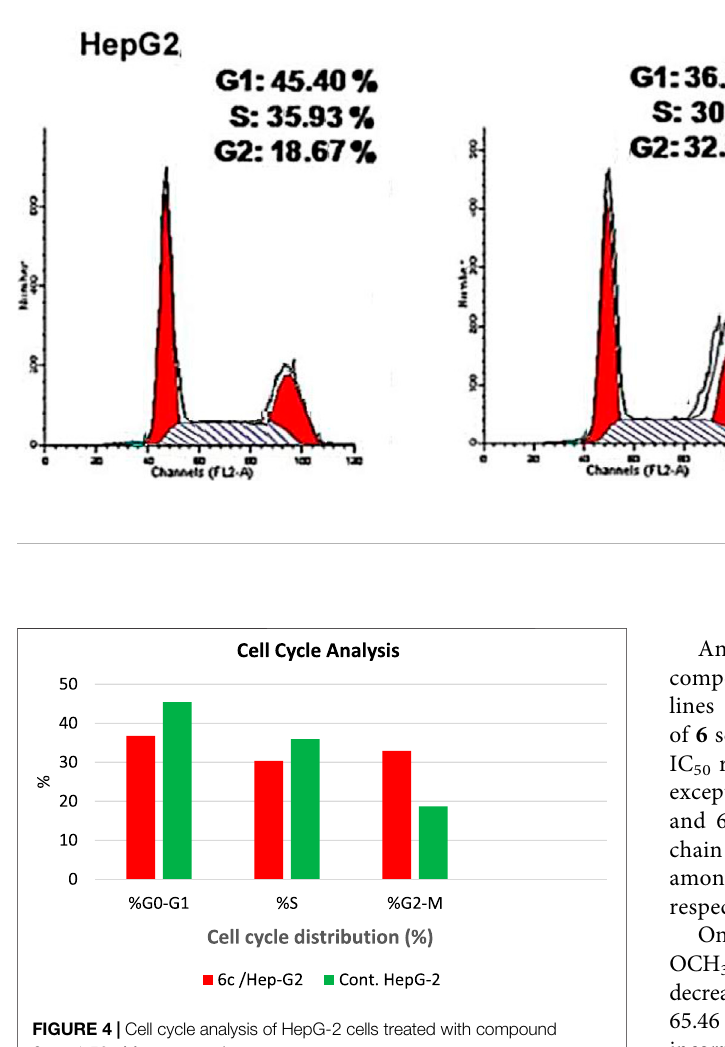
FIGURE 4 | Cell cycle analysis of HepG-2 cells treated with compound 6 c at 1.53 µM concentration.